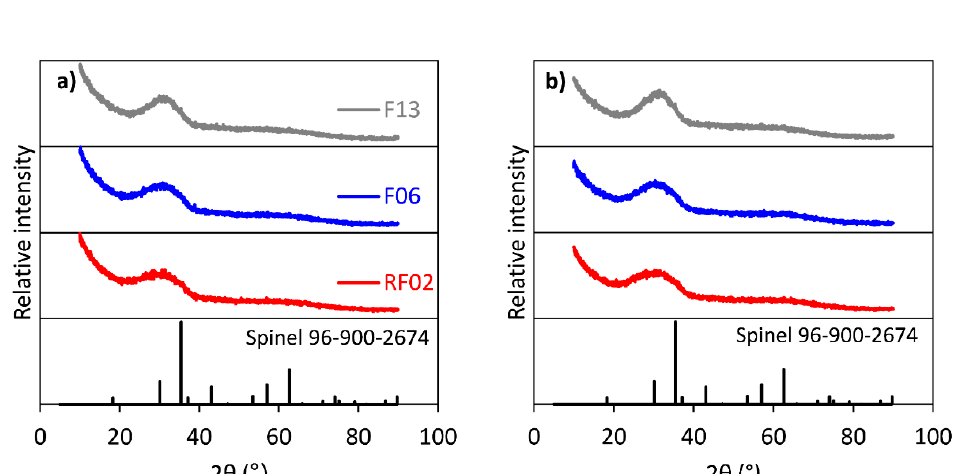
Figure 2. XRD patterns ( a ) before and ( b ) after dynamic leaching of RF02, F06, and F13 samples.